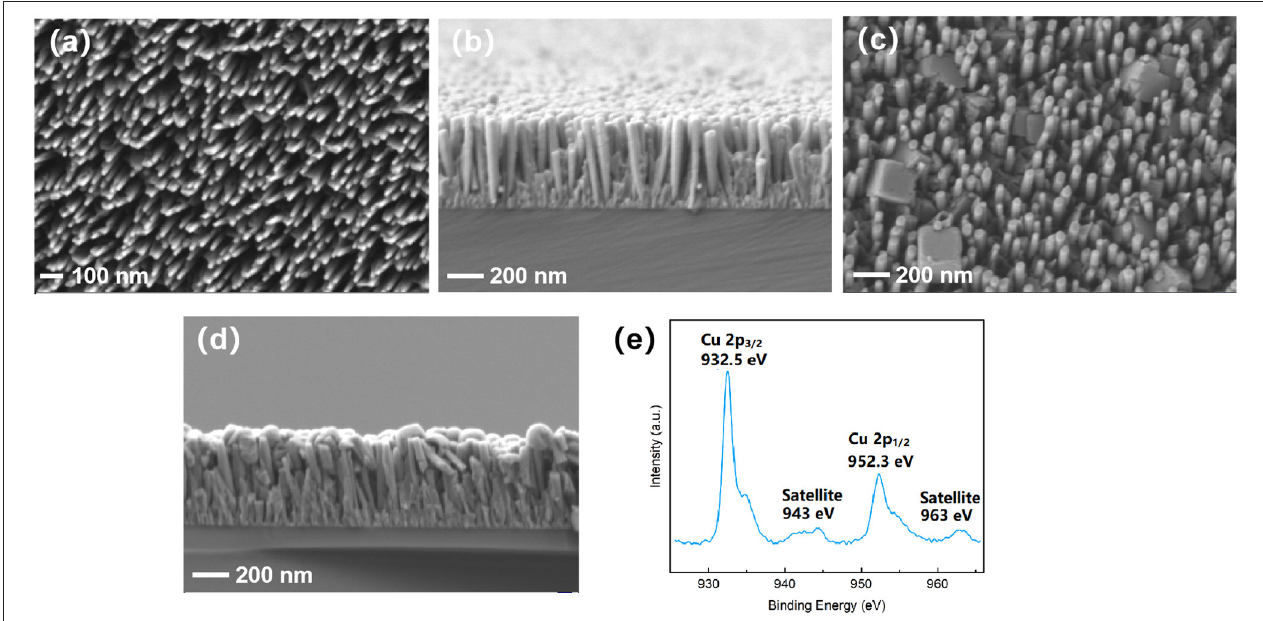
FIGURE 1 | Top-view- and cross-sectional SEM images of the (a,b) bare InGaN nanowires (NWs) and (c,d) InGaN NWs after 40s Cu 2 O electrodeposition. (e) X-ray photoelectron spectroscopy taken several days after Cu 2 O